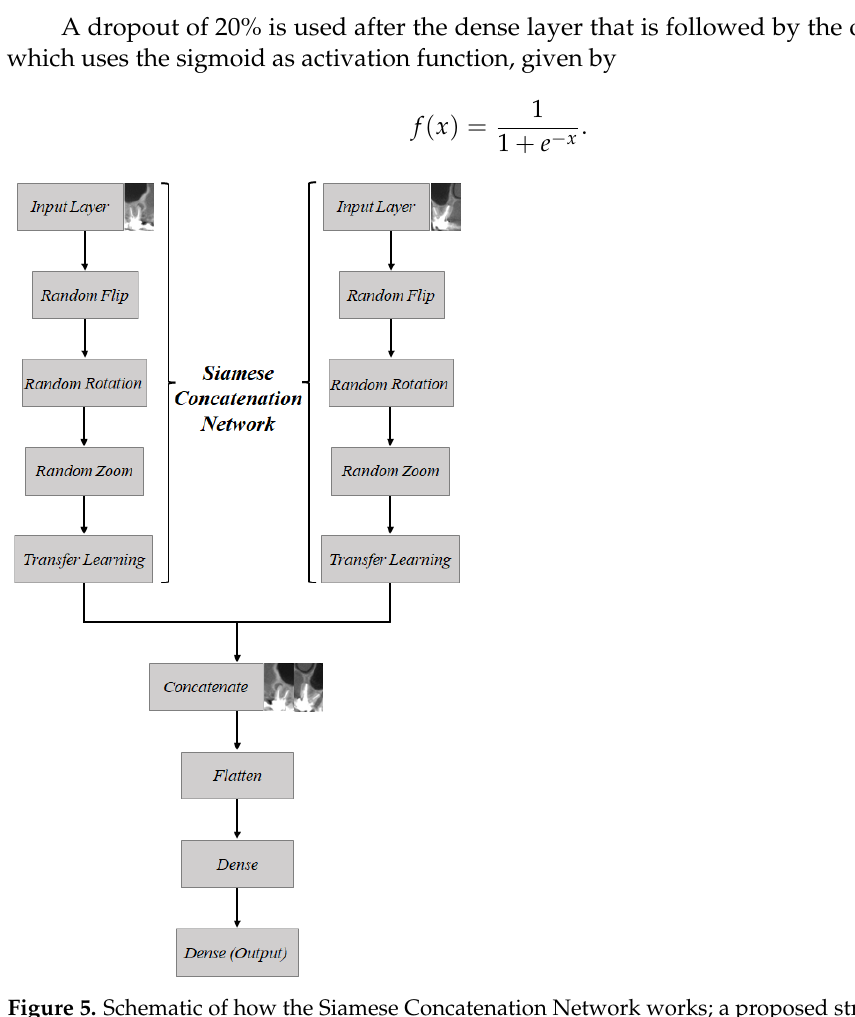
Figure 5. Schematic of how the Siamese Concatenation Network works; a proposed strategy using a Siamese Network for joining pairs of